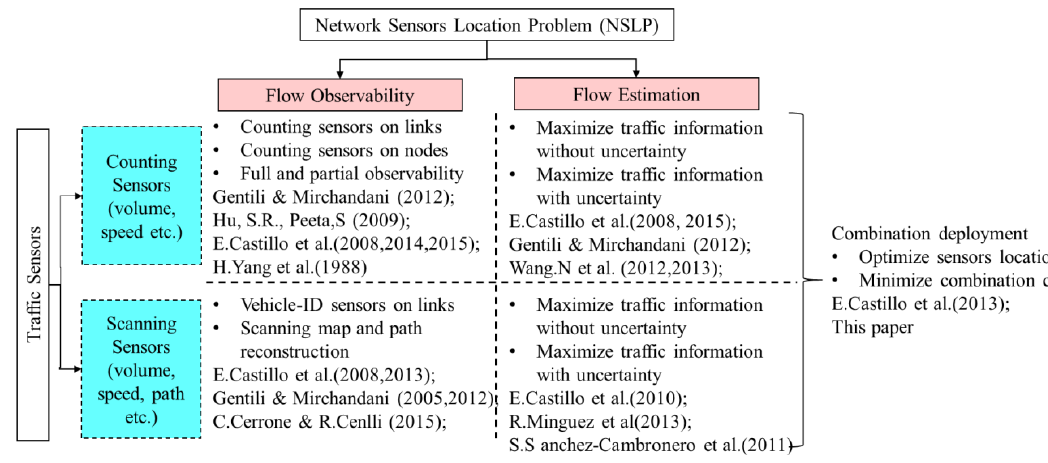
Figure 1. Classification of sensor location problem in the traffic network.